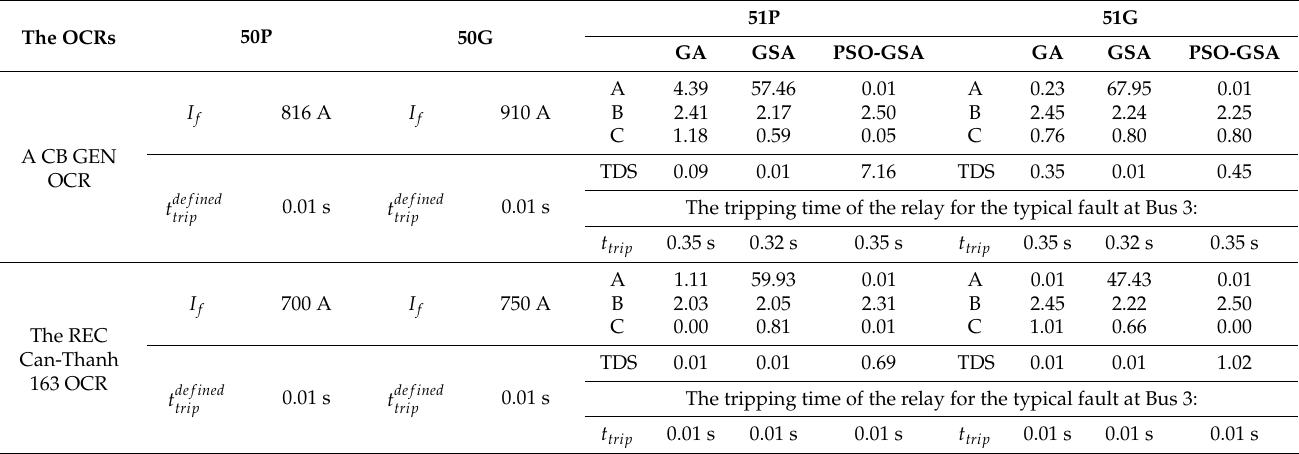
Table 6. Optimal protection coordination results of the OCRs in Scenario 3 and their tripping time when the fault is at Bus 3. The